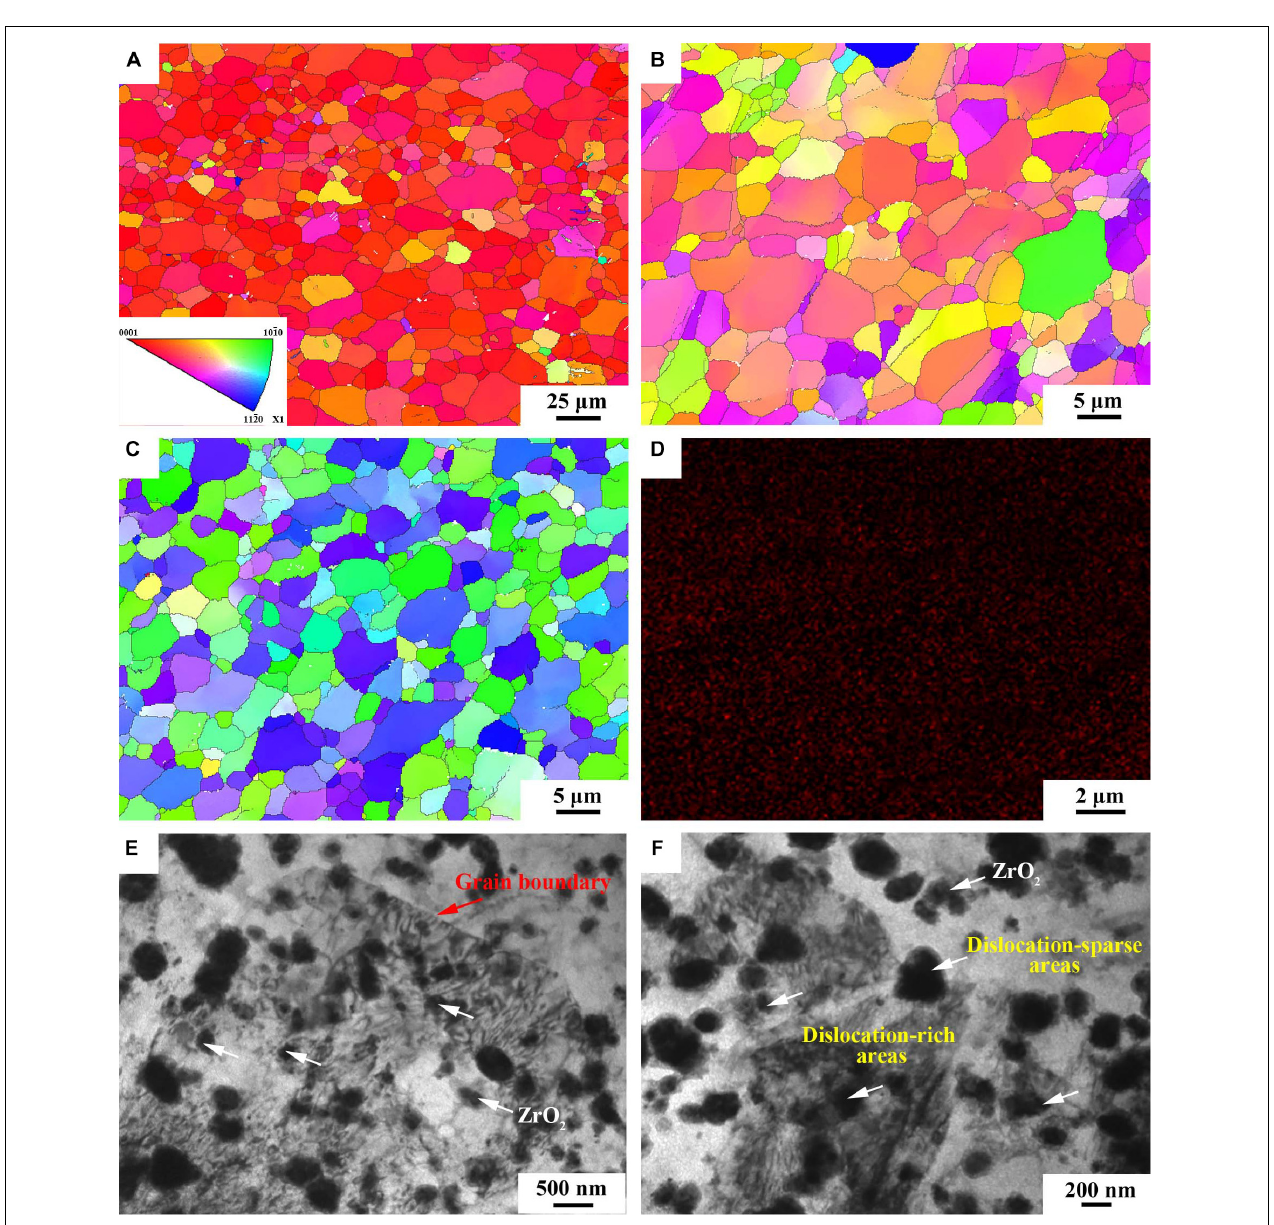
FIGURE 3 | The IPF map of (A) BM, (B) FSP and (C) FSP-ZrO 2 ; (D) The EDS map of FSP-ZrO 2 sample; (E) and (F) TEM images of FSP-ZrO 2 sample,